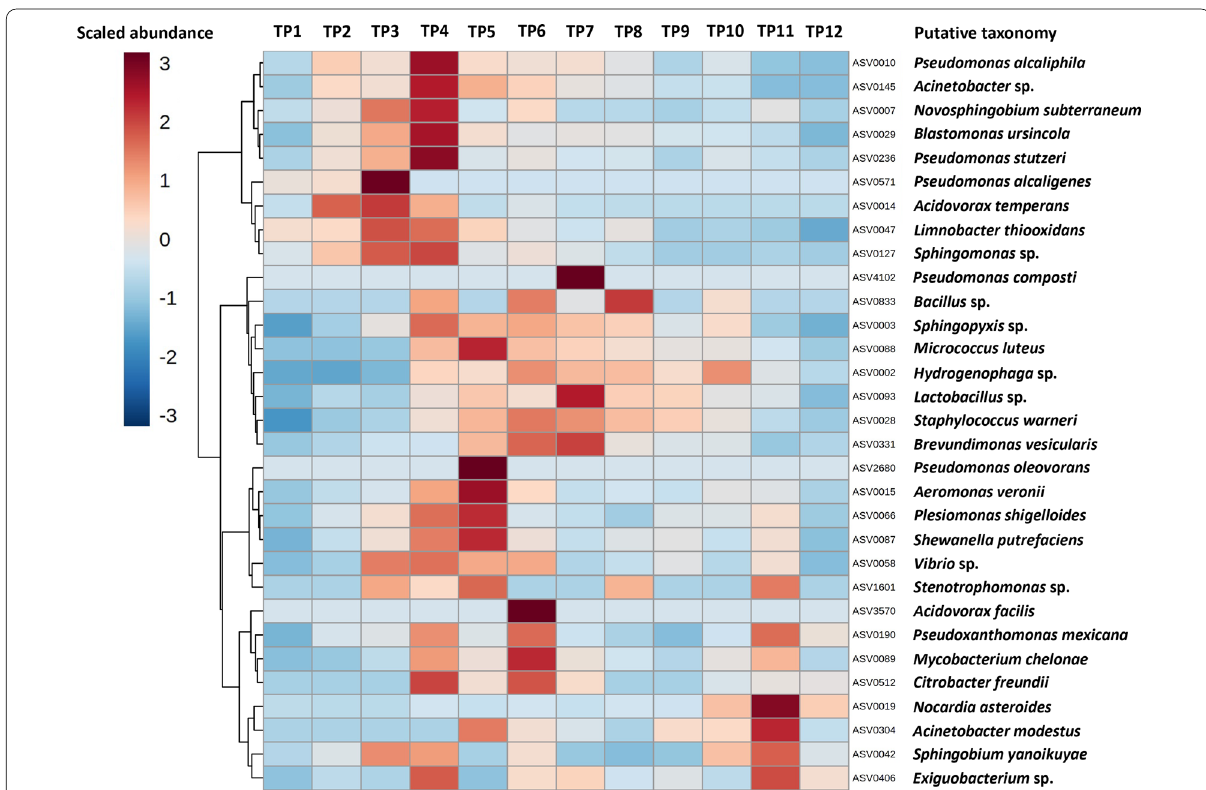
Fig. 7 Cultivable taxa expand early during equilibration. Heatmap showing cube root-transformed mean relative abundance (legend upper left) at each time point (TP), of amplicon sequence variants (ASVs) matching the taxonomies assigned to culture isolates via